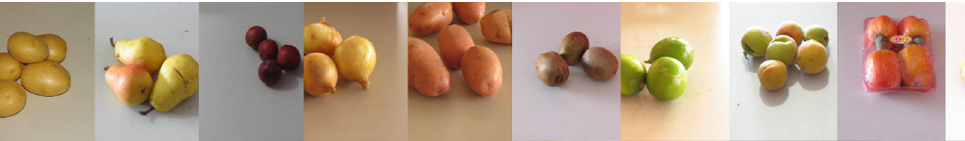
1000 dataset, such as buses, animals, flowers, beaches, peo- ple, and natural scenes. The Coral 1000 datasets contain a variety of image semantics that are useful for image detec- tion, as shown in Fig. 17. The resolution of images of the Corel 1000 dataset is 256 ×